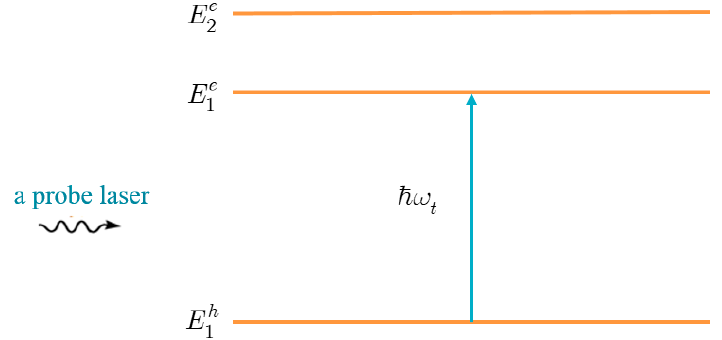
Figure 2. Schematic view of a three-level system, without the presence of a pump laser. Additionally, the system is irradiated with the use of two lasers, operating simultaneously. The coupling of the electron states is provided by one, namely the pump laser. The interband absorption spectrum is identified by another, the probe laser. These laser beams are projected onto the same cross-sectional area of the QD. The laser electric fields stay in the Oxy -plane, since their direction of propagation is assumed to be parallel to the Oz axis (see Figure 1a). The form of these lasers is as follows: